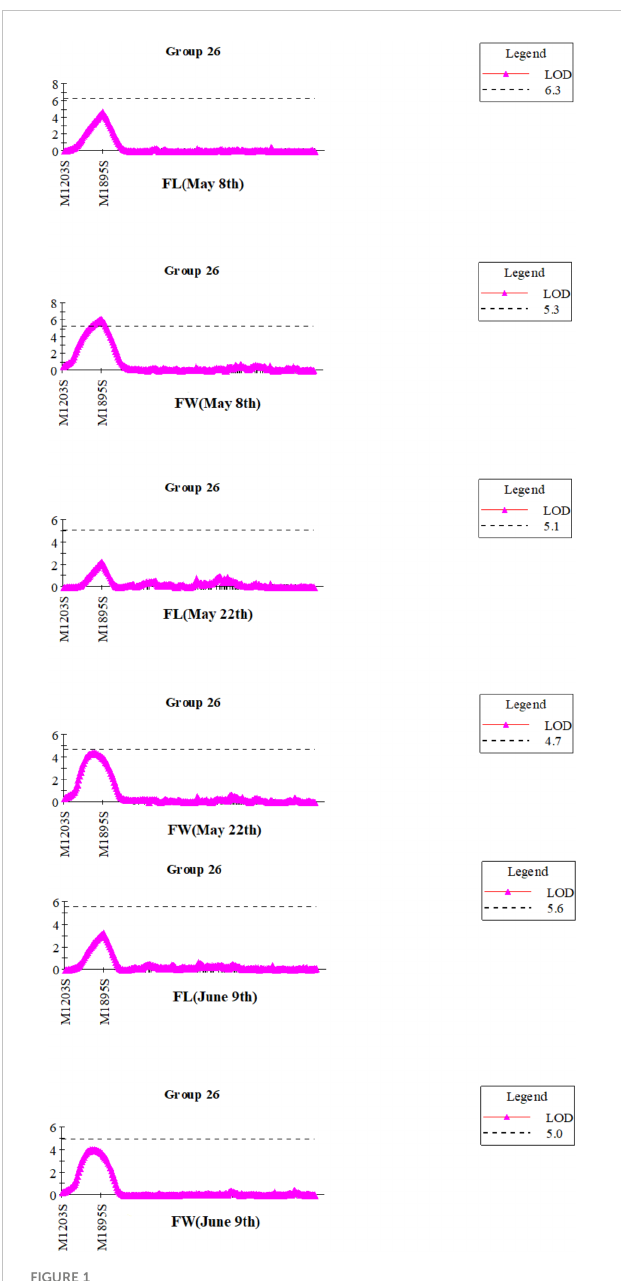
FIGURE 1 QTL mapping for the blade length (FL) and width (FW) of S.japonica in integrated linkage group 26 at three observation days by IM method in